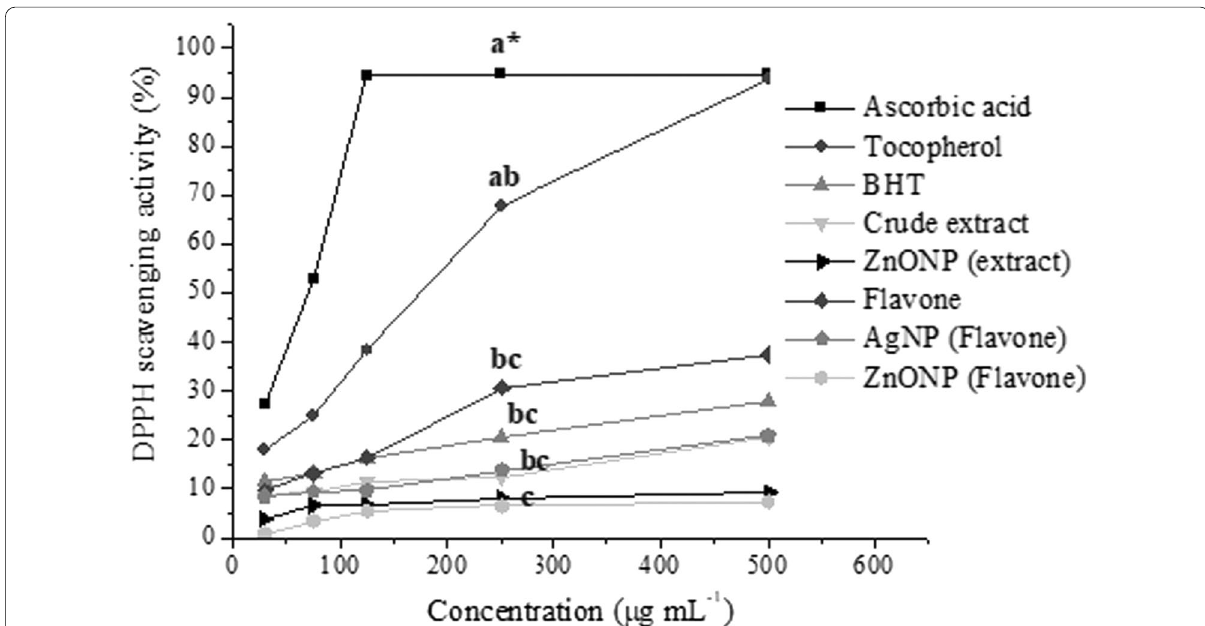
Fig. 6 DPPH radical scavenging activity of H. aureonitens extract, flavone and nanoparticles (AgNPs and ZnONPs) synthesized using H. aureonitens extract and isolated flavone. Ascorbic acid, tocopherol and butylated hydroxytoluene (BHT) were used as controls. Different alphabets indicate mean separation by Turkey’s post hoc test ( p <